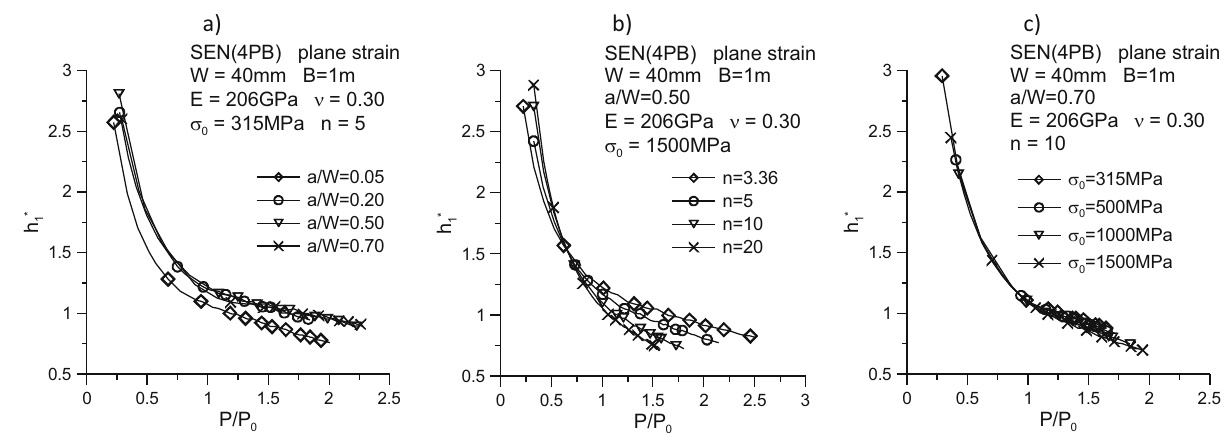
Figure 7: In fl uence of the relative crack length a / W ( a ) , the strain hardening exponent n in the R – O law ( b ) , and the yield point σ 0 ( c ) on the value of the h 1⁎ function for the entire external load